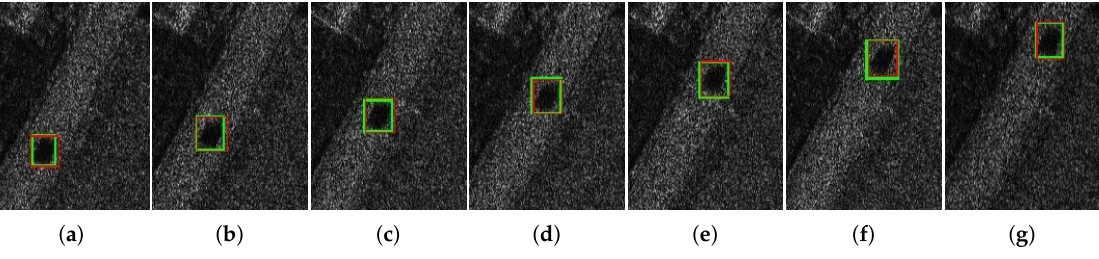
Figure 15. Partial tracking results of Re 3 of simulated video-SAR data. Green rectangles are the true trajectory of target, and red rectangles represent tracking results. ( a – g ) are the corresponding results of frame 1, 10, 20, 30, 40, 50 and 60,